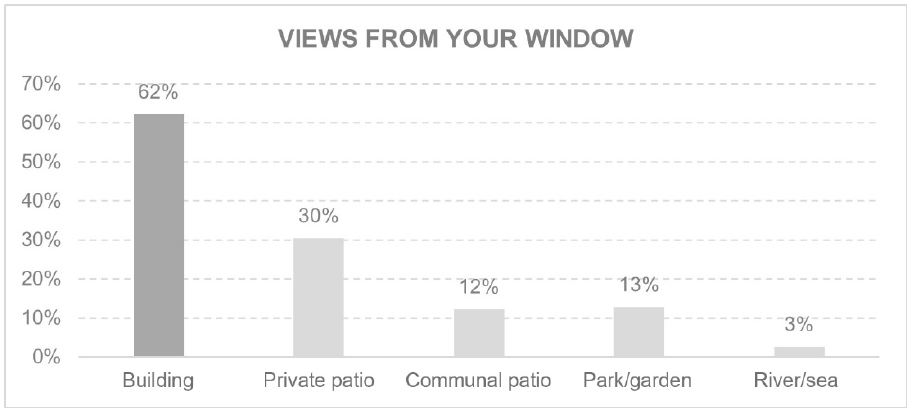
Figure 8. Views from your window.